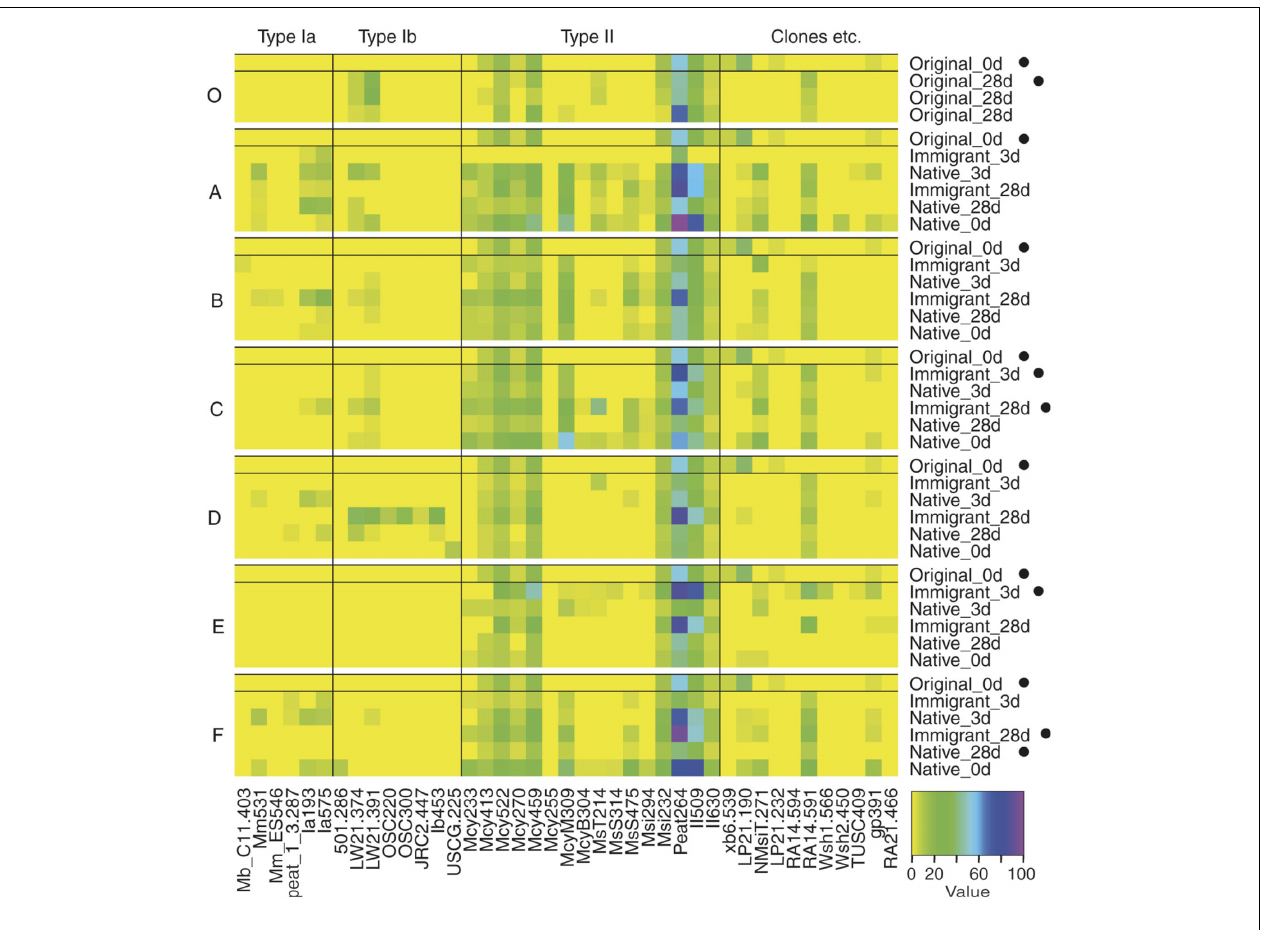
FIGUREA2 | Heatmap of semiquantitative microarray results. Each site (A–F and O) is showed separately together with the original 0day sample data for comparison. Microarray analysis was successful for only one of three parallel inactive original_0day samples. Samples that were inactive in CH 4